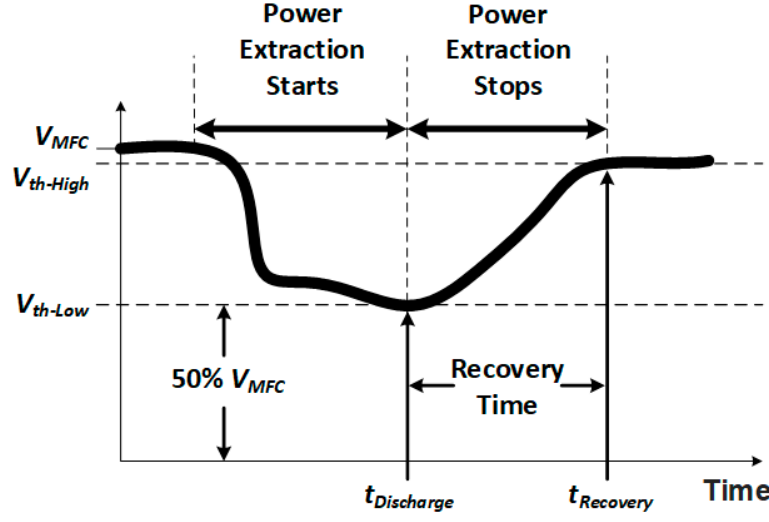
Figure 5. Key algorithm reference points of MFC power extraction waveform.